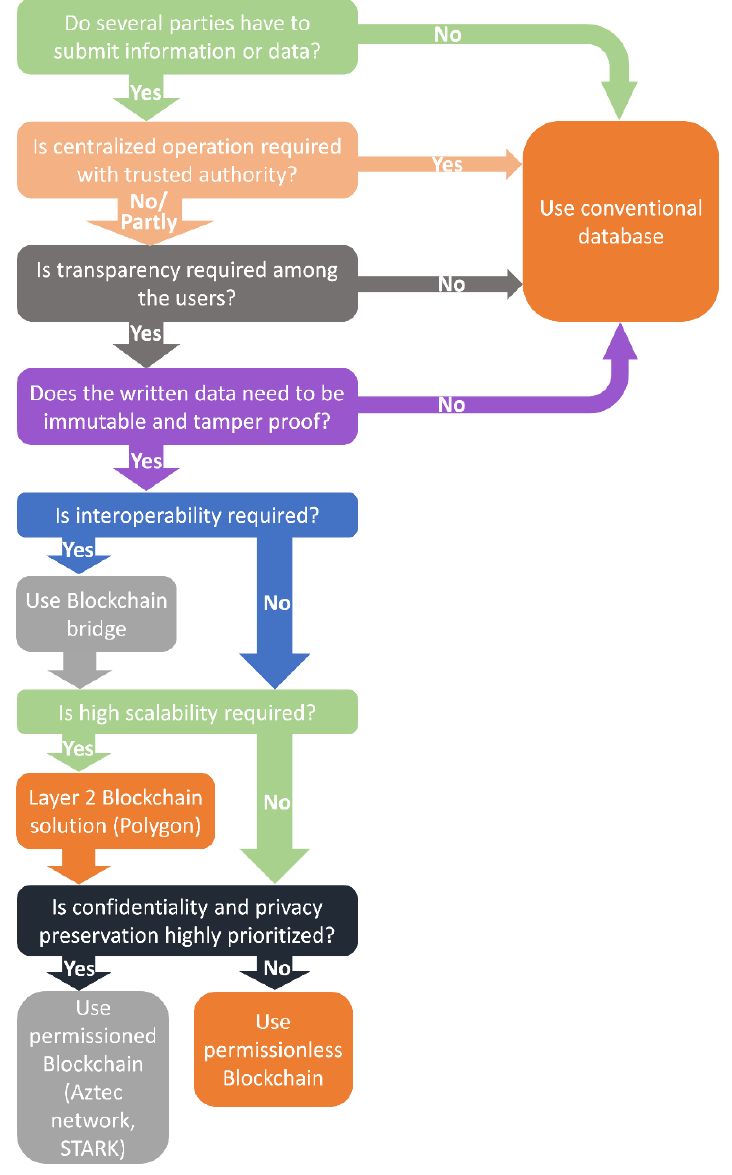
Figure 8. Flow diagram to evaluate the suitability of Blockchain application in electrical power system.